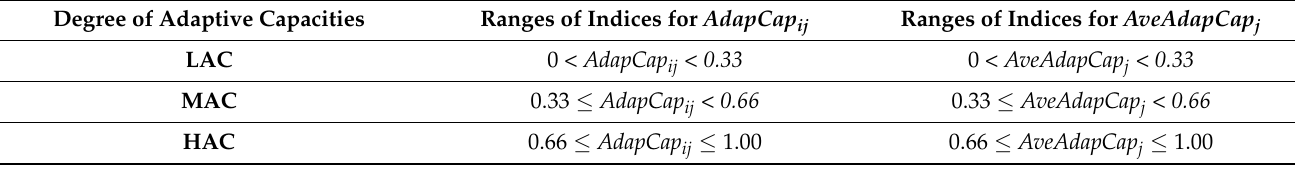
Table 2. Degree of farmers’ capacities of